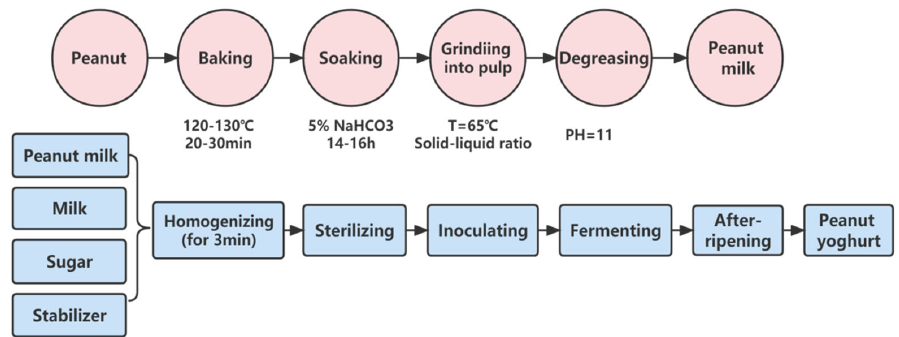
Figure 1. Process flow chart showing some common methods and steps used for production of pea ‐ nut protein and peanut yogurt.